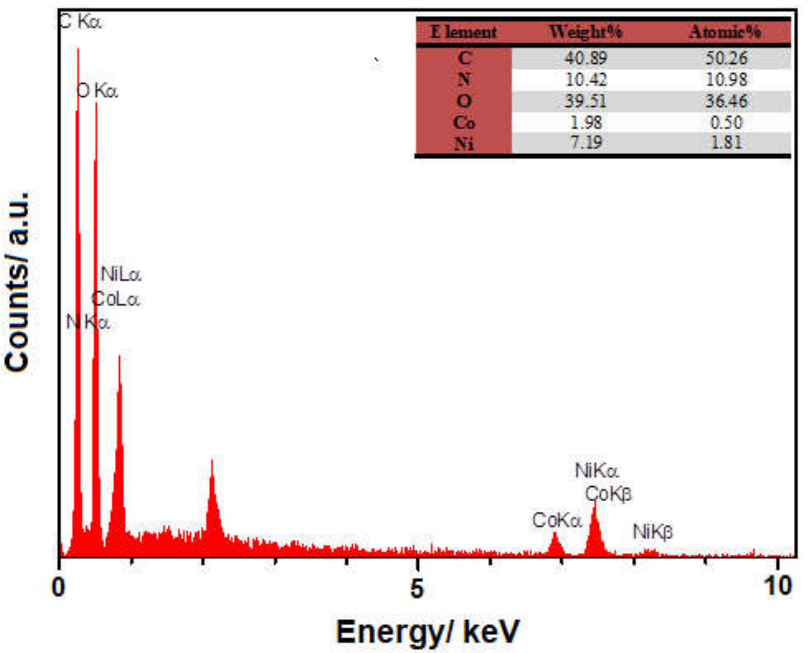
Figure 2. EDS spectrum prepared from as-constructed bimetallic NiCo-MOF nanosheets.